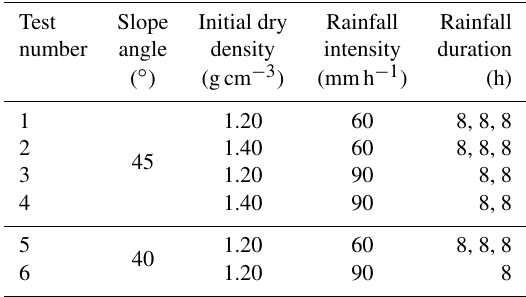
Table 1. Scheme of artificial flume model